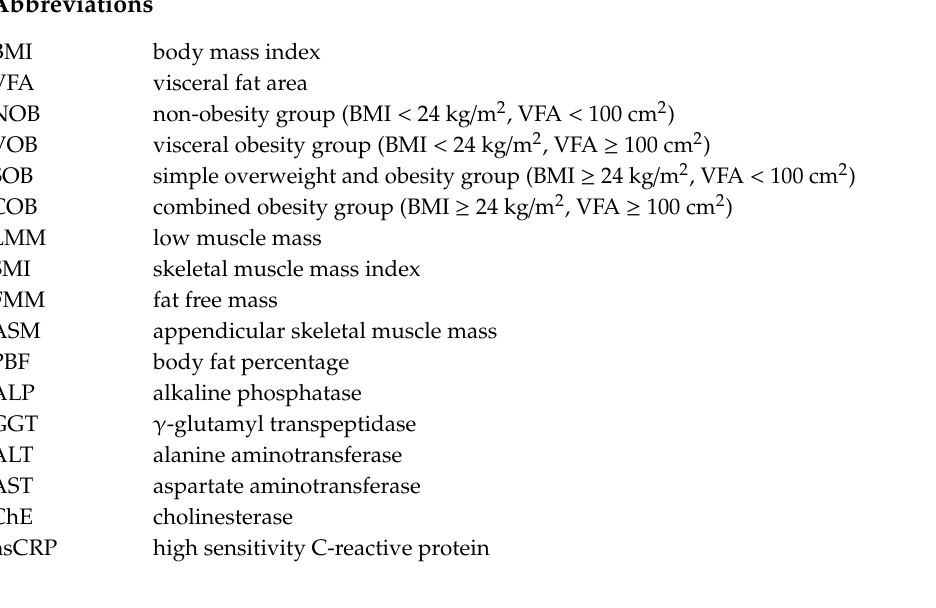
Figure S1: Regression nomogram for the screening of LMM in community-dwelling older people. Figure S2: Regression nomogram for the screening of sarcopenia in community-dwelling older